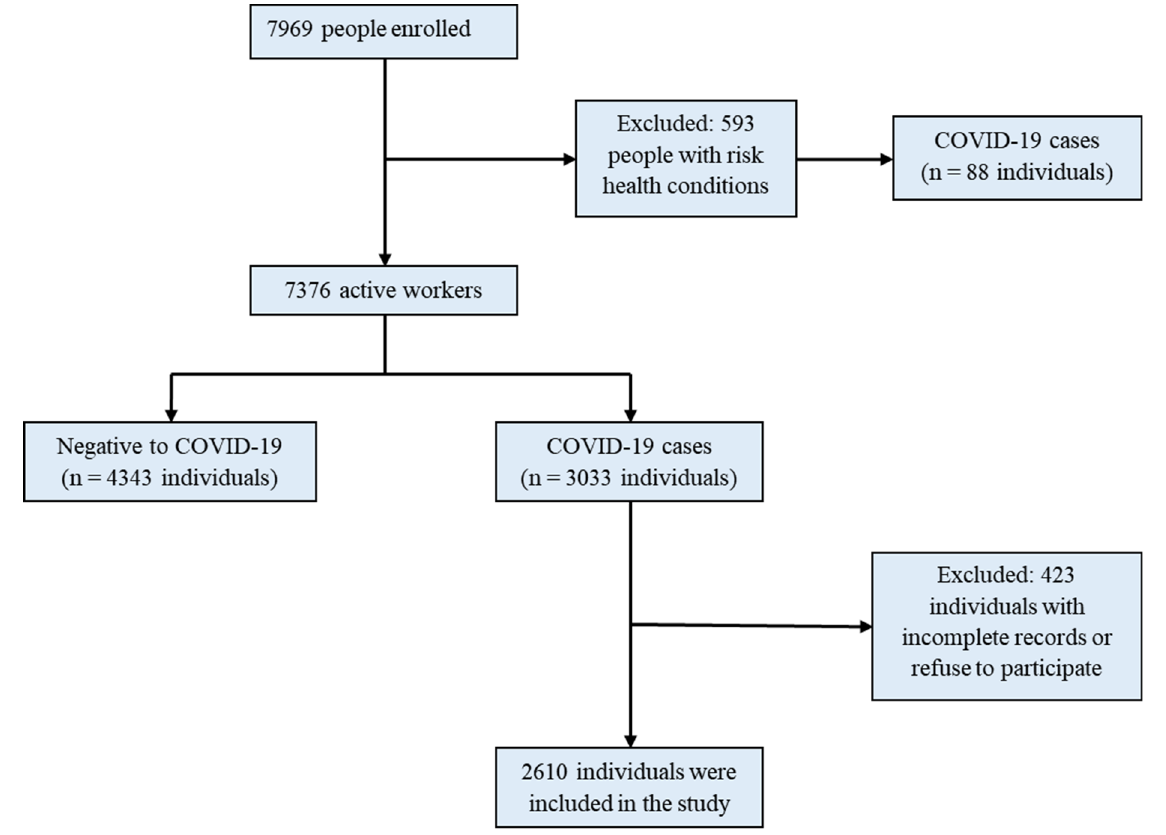
Figure 1. Flow chart of healthcare workers’ enrollment process to the study.